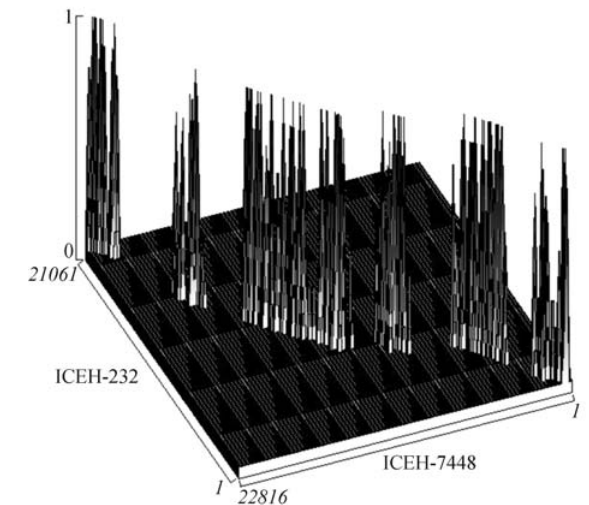
Figure 2 - Word density 3D plot of the ICEH-232 and ICEF-7448 se- quences. The peaks correspond to the word density match (number of nu- cleotide local sequence similarities in a region) between the sequences of the elements, where more elevated peaks denote higher similarity. Loca- tion of the peaks in the base plan is determined by the coordinates of the word matches between the two sequences, represented in the X-Z axis.